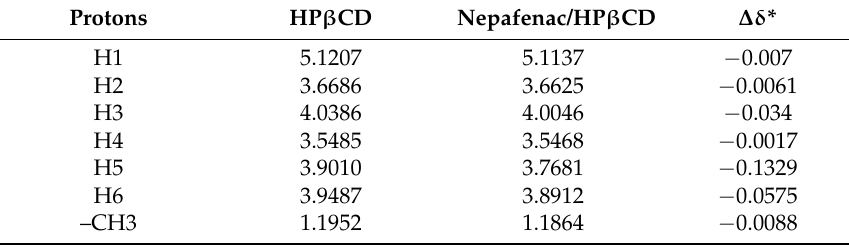
Table 5. H-NMR Chemical shift corresponding to free HP β CD alone and in the presence of nepafenac.